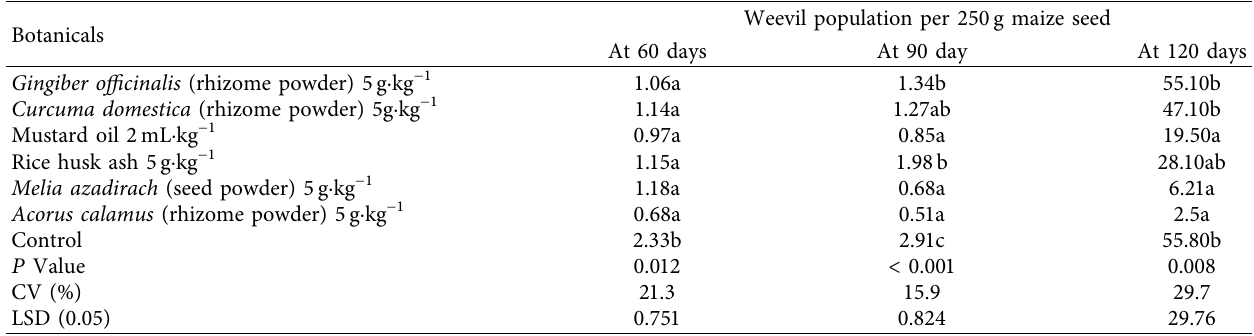
Table 1: Efects of diferent botanicals on weevil population in maize seeds.